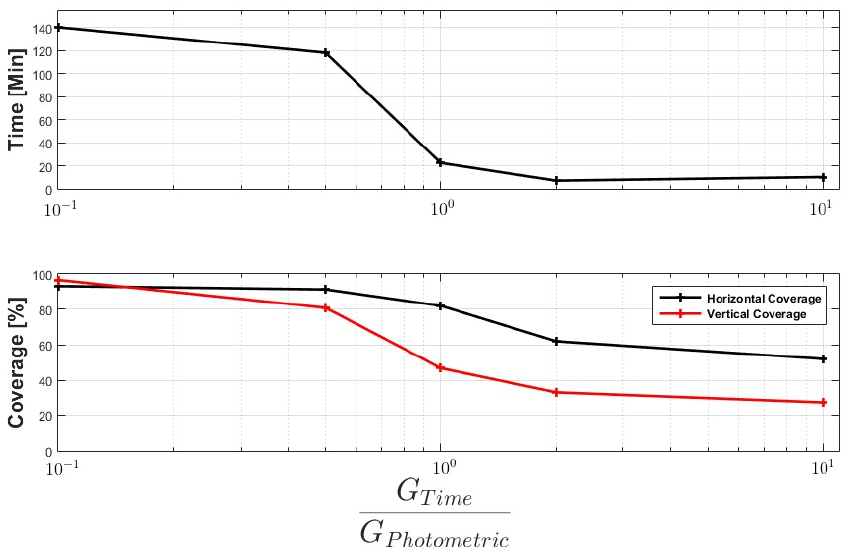
Figure 14. Comparison between G Time and G Photometric and its impact in objectives of the meta heuristics: time of mission, horizontal, and vertical